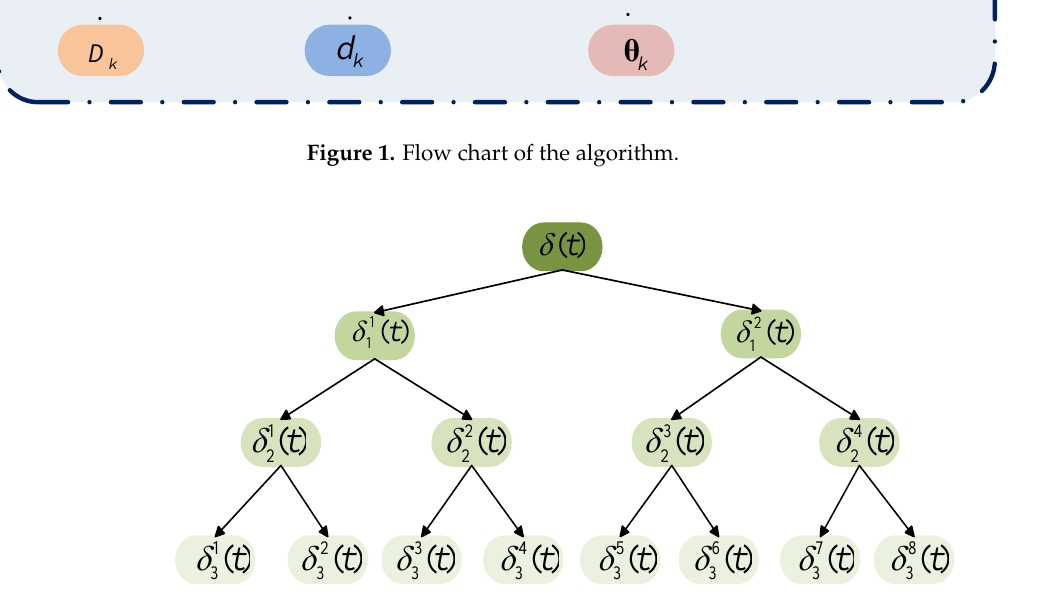
Figure 2. Wavelet packet dendrogram.